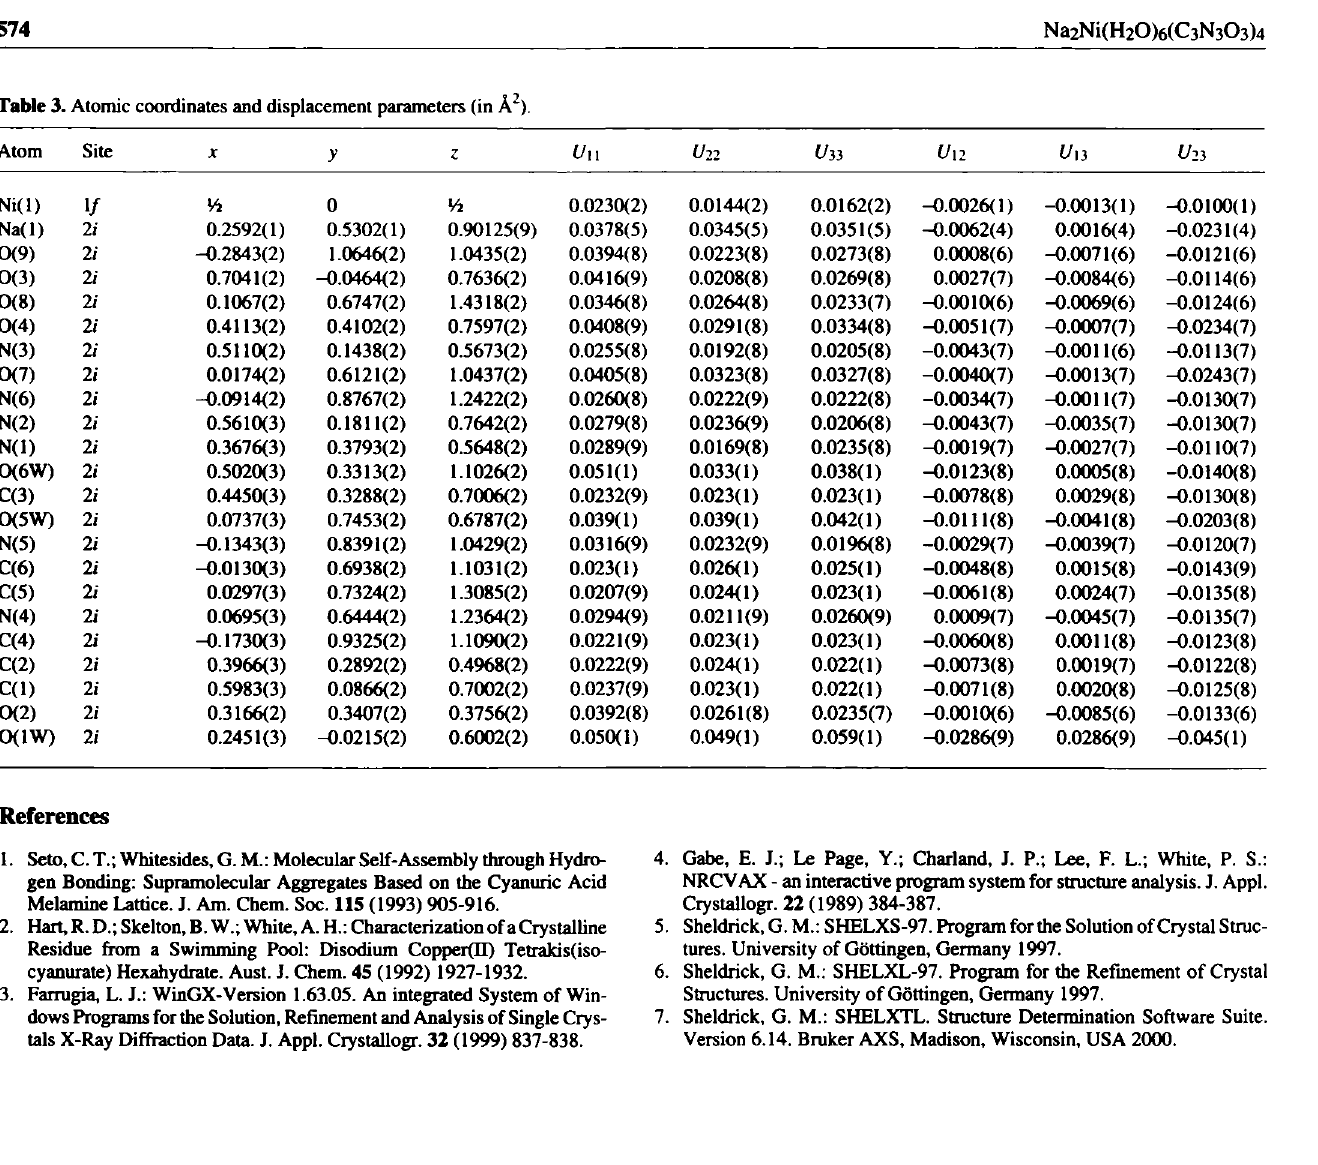
Table 3. Atomic coordinates and displacement parameters (in Â 2